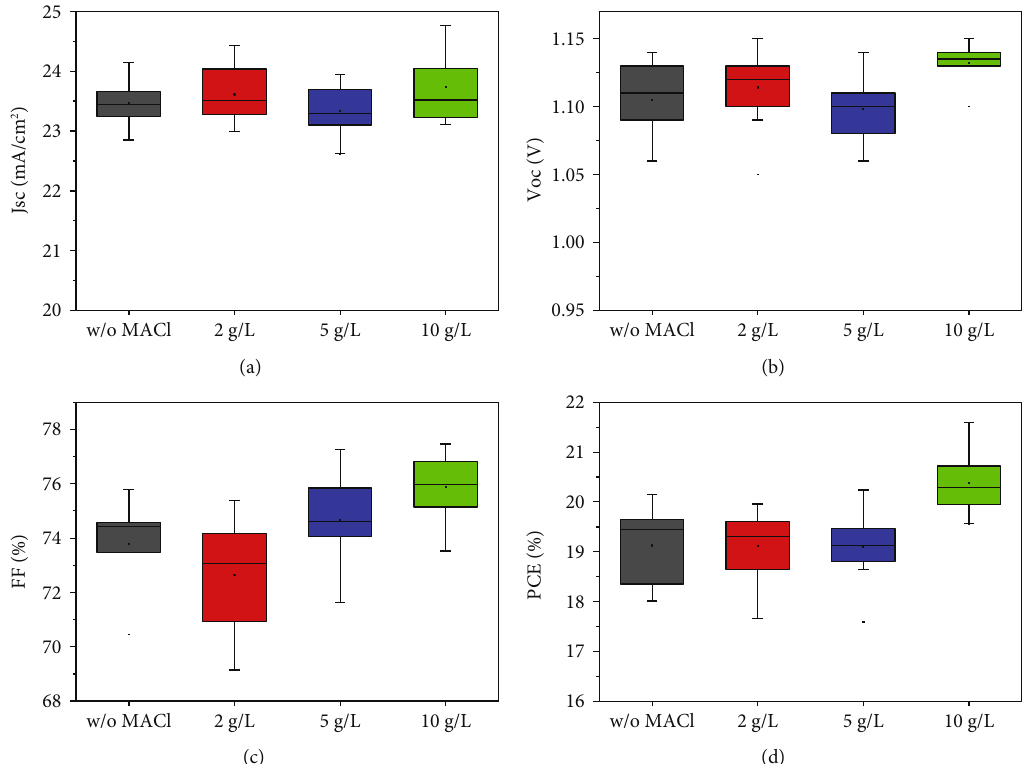
Figure 7: The box charts of photovoltaic parameters of PSCs added di ff erent concentrations of MACl: (a) J